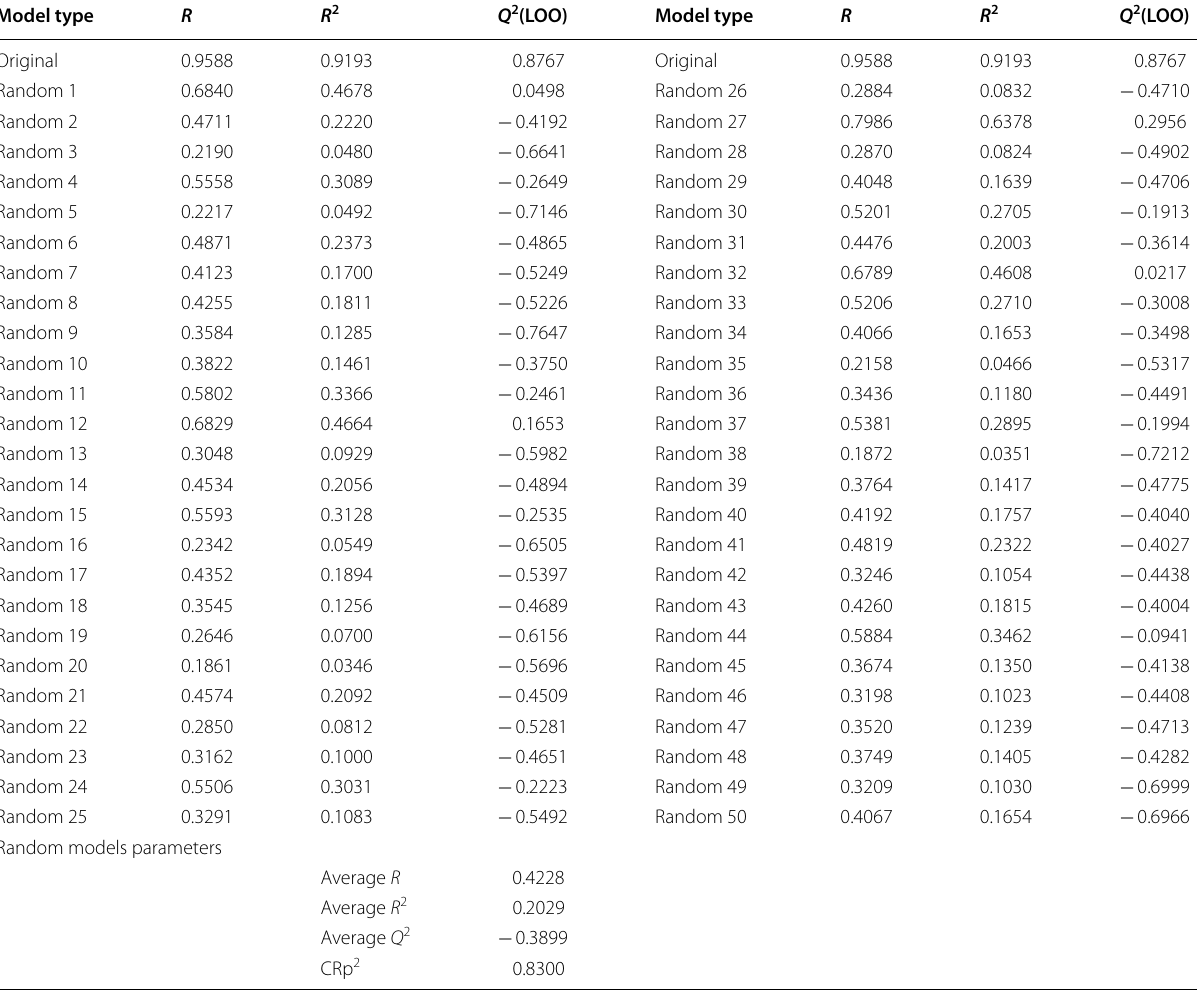
Table 4 Y-randomization test of the model descriptors Model type